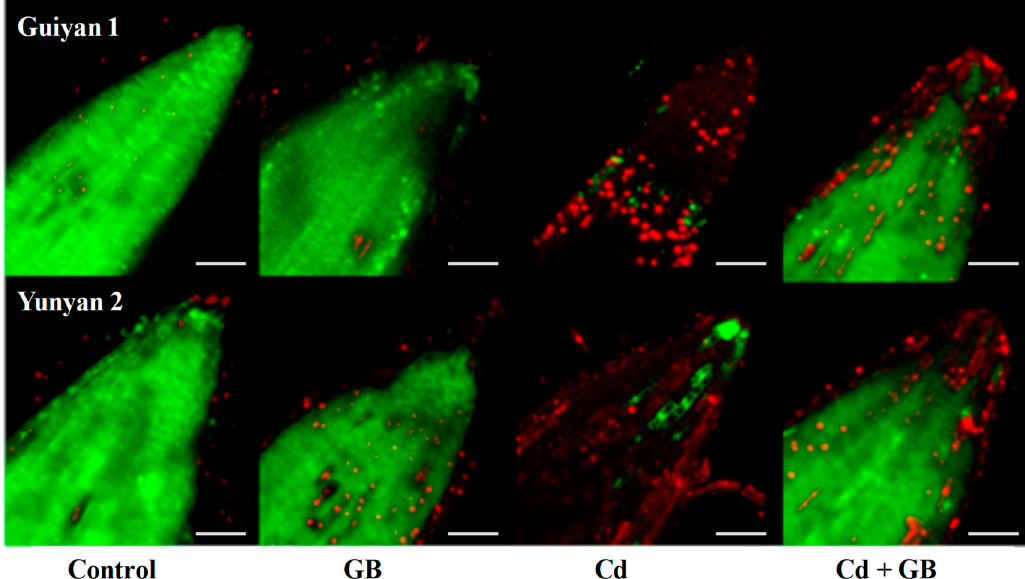
Figure 2. The effects of Cd and exogenous GB on the cell vigor in the root tips of Guiyan1 and Yunyan2 detected by an flurescein diacetate-propidium iodide (FDA-PI) dual fluorescent dye after 15 days of Cd exposure: The green and red fluorescence indicate the fluorescent dye in living and dead cells, respectively. Control, GB, Cd, and Cd + GB correspond to BNS + foliar spray of deionized water, BNS + foliar spray of 500 µ M GB, BNS + foliar spray of deionized water + 5 µ M CdCl 2 , and BNS + foliar spray of 500 µ M GB + 5 µ M CdCl 2 , respectively. Scale bars = 250 µ m. The figure is representative of three different experiments.